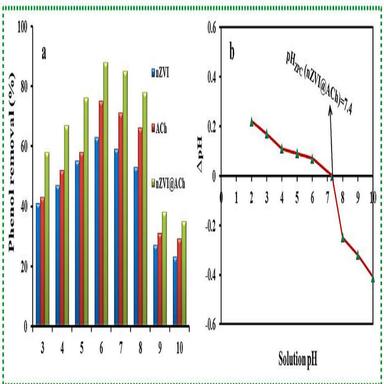
(a) Effect of pH in the adsorption capacities of phenol and (b) the pH of zero-point charge of the nZVI@ACh.